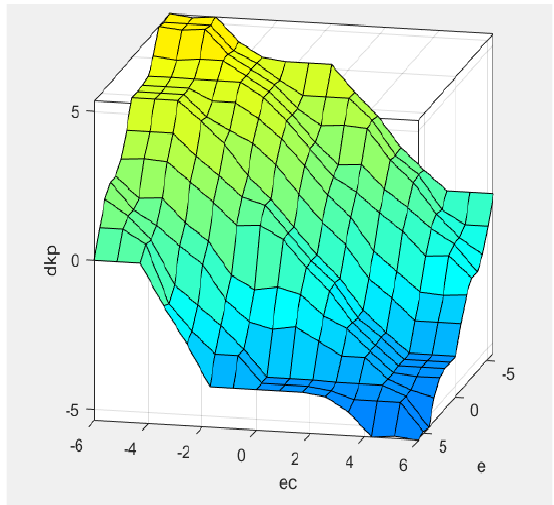
output surface. Figure 3. ∆ k p